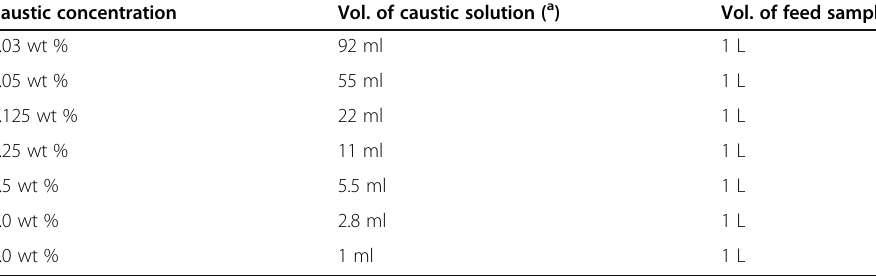
Table 4 Volume of caustic solution used in the treatment process Caustic concentration Vol. of caustic solution ( a